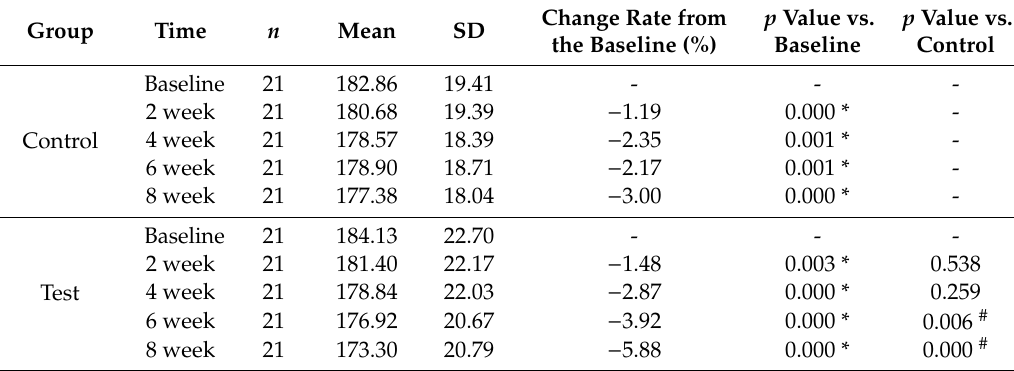
Table 4. Melanin index of the control and test